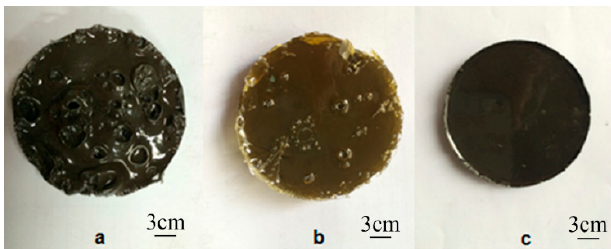
Figure 5. Morphologies of the samples obtained at different curing temperatures: ( a ) 80 °C, ( b ) 70 °C, and ( c ) 75 °C.